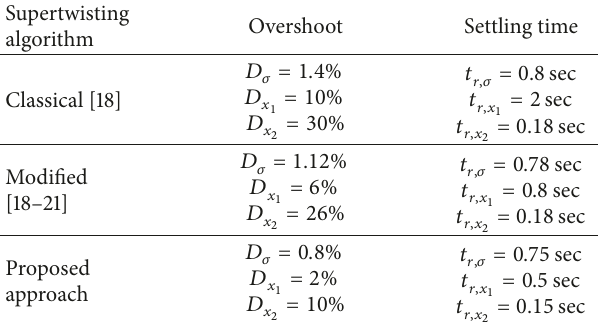
Table3:Comparisonperformancesofthesuper-twistingalgorithm. Supertwisting algorithm